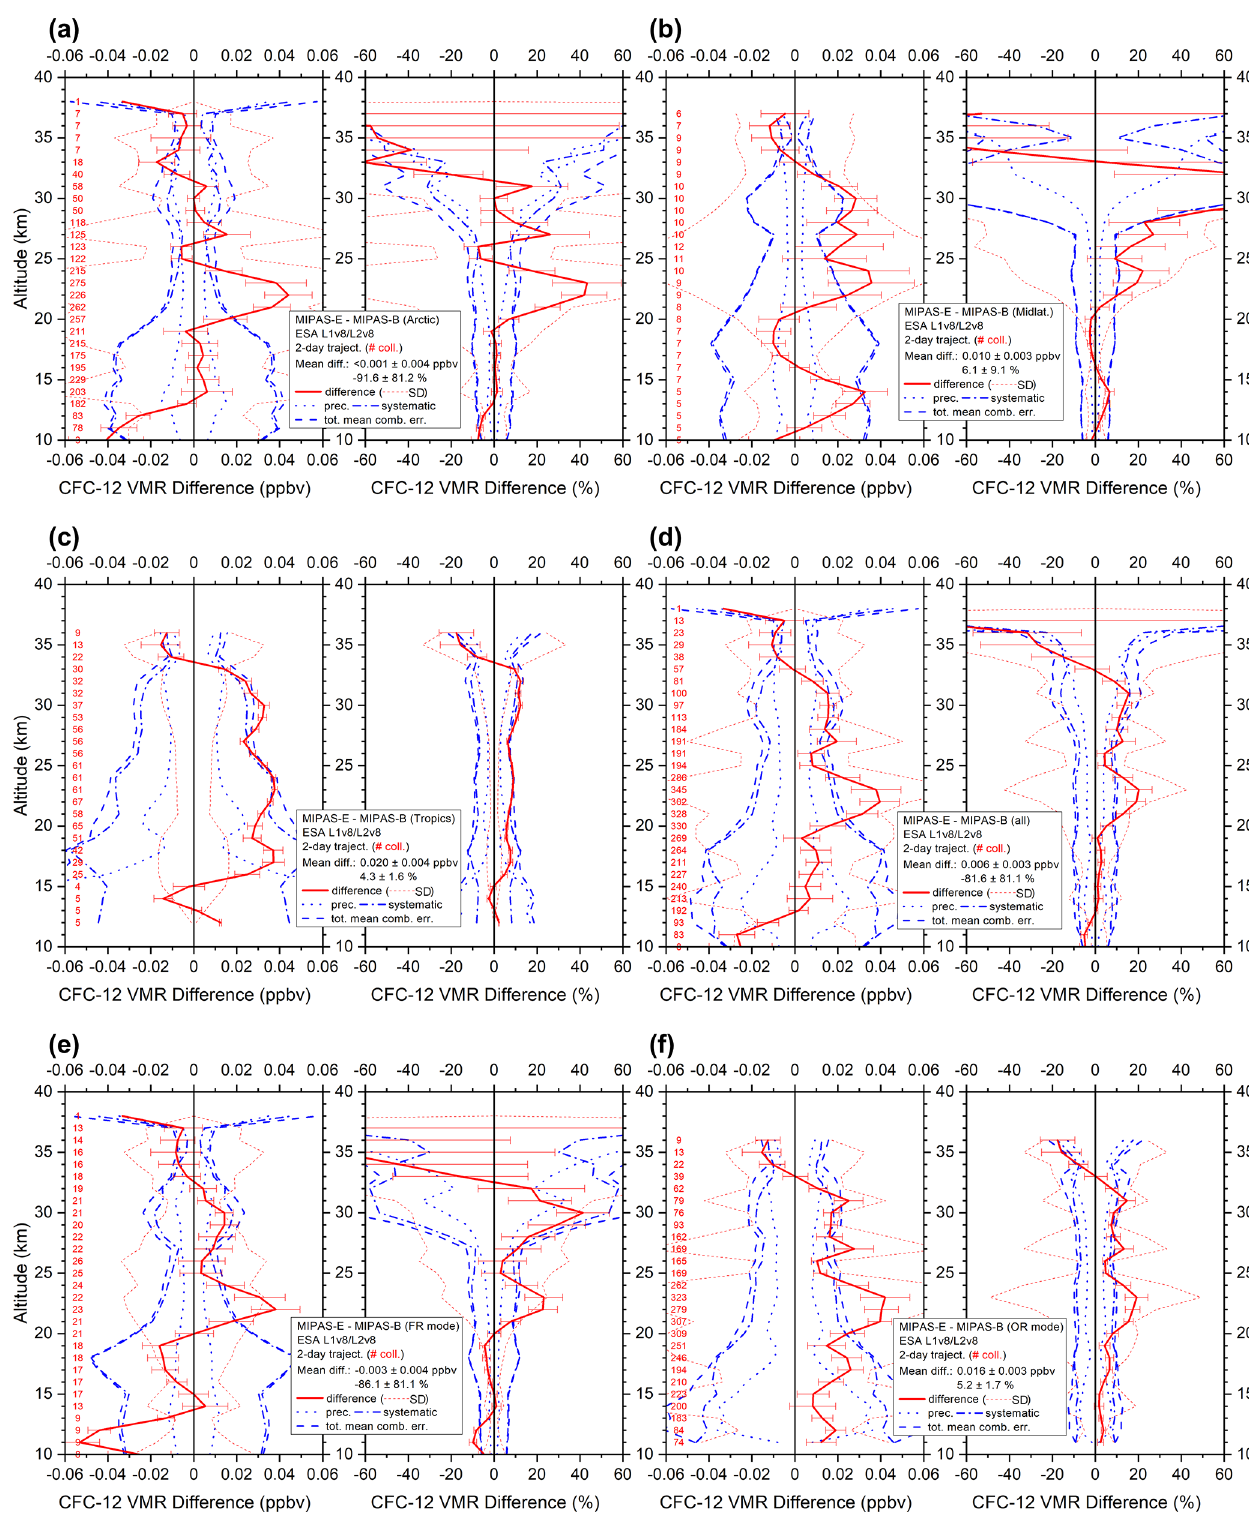
Figure 12. Same as Fig. 3 but for